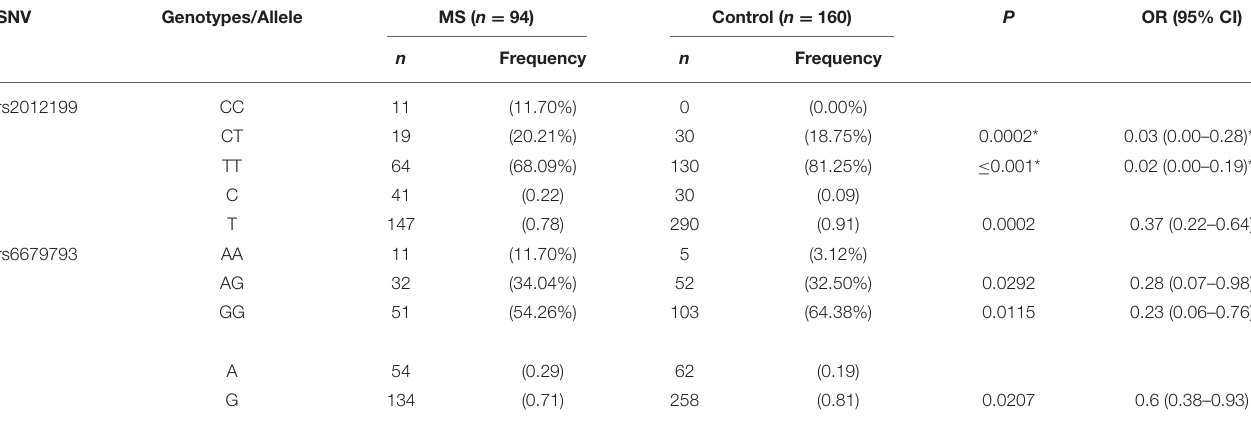
TABLE 2 | The genotypes and allele frequencies of the investigated SNVs of FCRL5 gene, in the studied groups. SNV